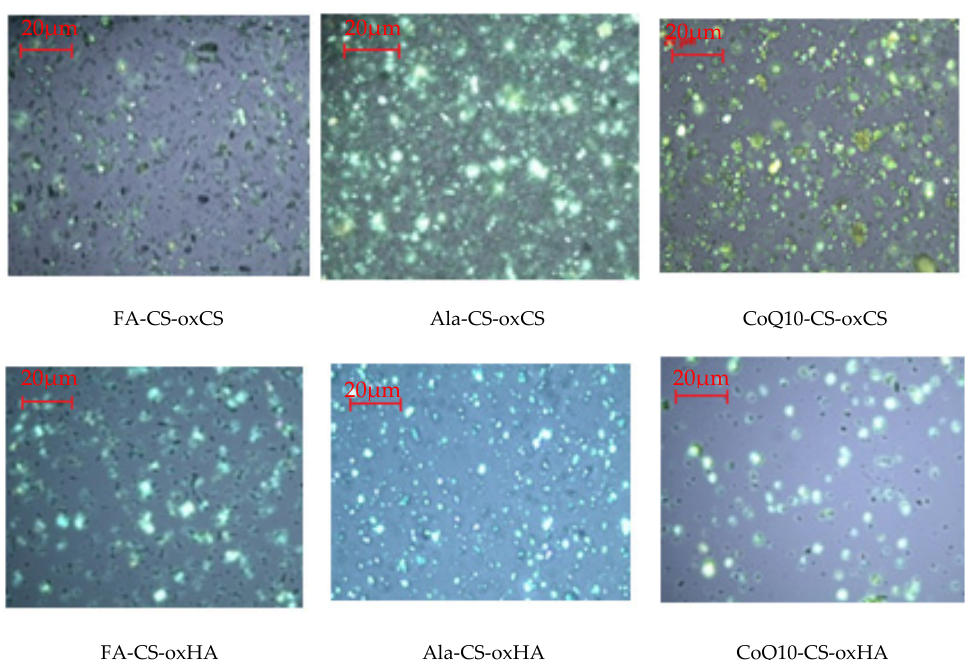
Figure 3. The microscopic aspect of API-CS-oxCS/oxHA hydrogels (40×).